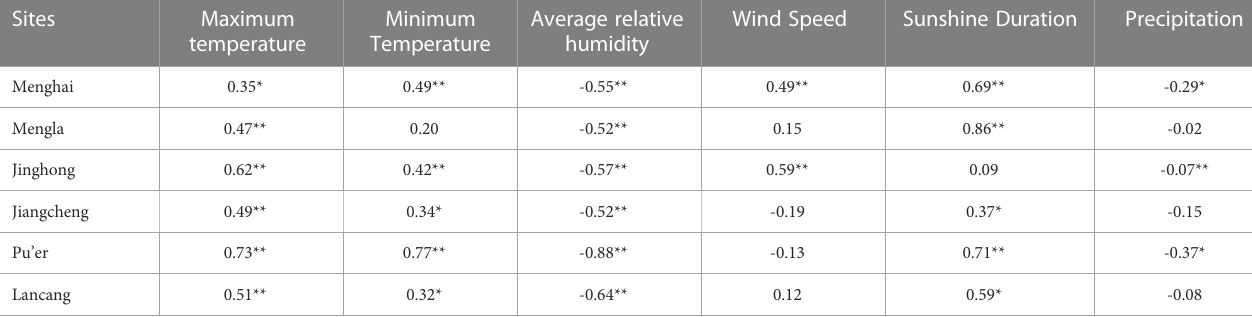
TABLE 4 Linear correlation coef fi cient between ET 0 of each station and annual mean meteorological elements.